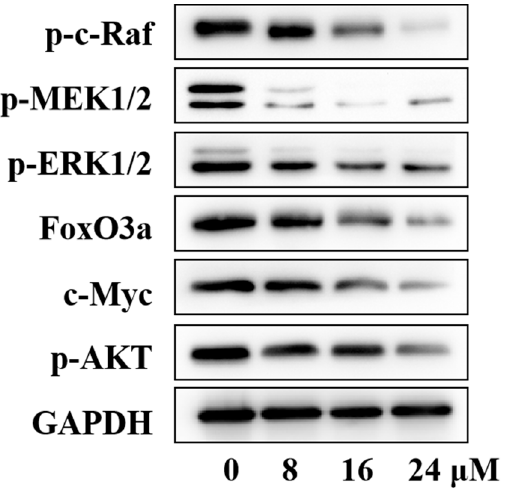
Figure 5. Inhibitory effects of compound H12 on MGC-803 cells. MGC-803 cells were treated with indicated concentrations of compound H12 for 48 h. The cell lysates were collected for Western blotting with the indicated antibodies.